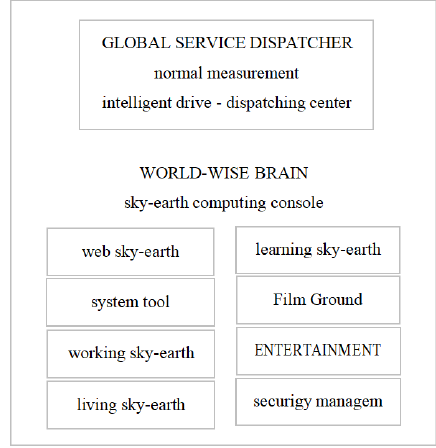
Fig. 3. Global service dispatcher as main component of world smart